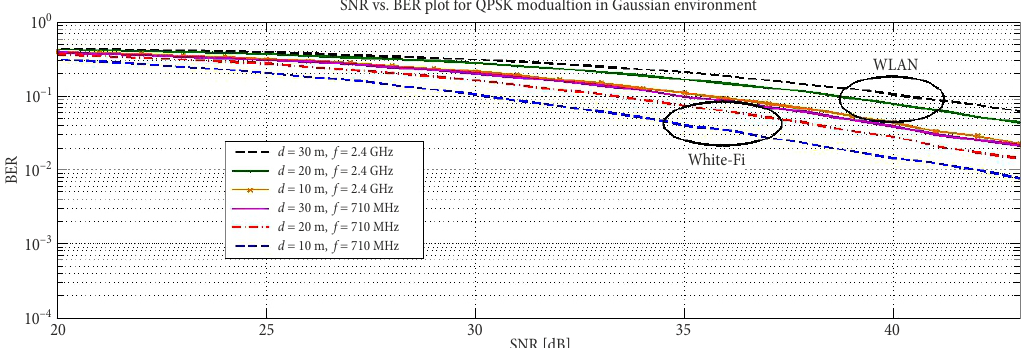
Fig. 6. BER vs. SNR for three characteristic WLANs and two White-Fi carriers’ frequencies SNR vs. BER plot for QPSK modualtion in Gaussian environment